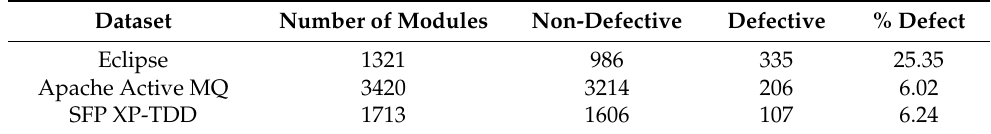
Table 5. The general short descriptions of all data